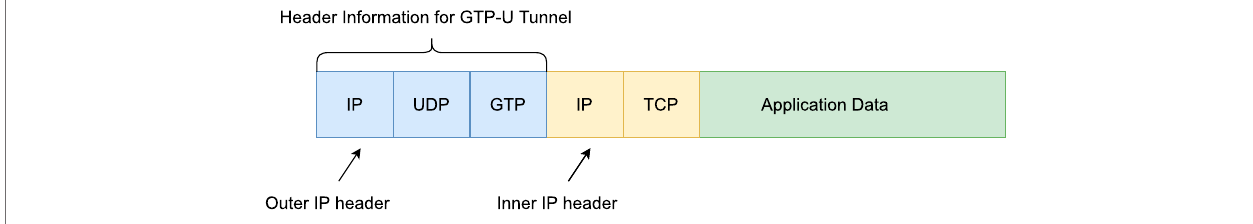
FIGURE 4 | Headers for data transfer across 5G GTP-U tunnel, Johnson (2019).